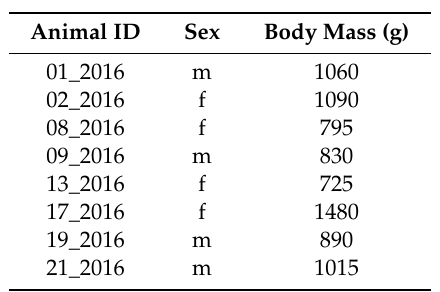
Table 1. Animal identification number (ID), sex and body mass (at the time of logger attachment) of the studied hedgehogs. Abbreviations in the sex column: m = male, f =